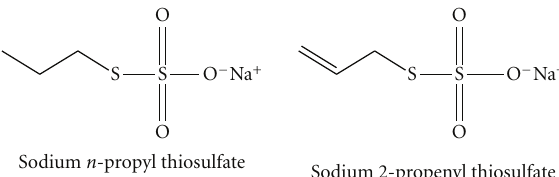
Figure 1: Structure of sodium n -propyl thiosulfate (NPTS) and sodium 2-propenyl thiosulfate